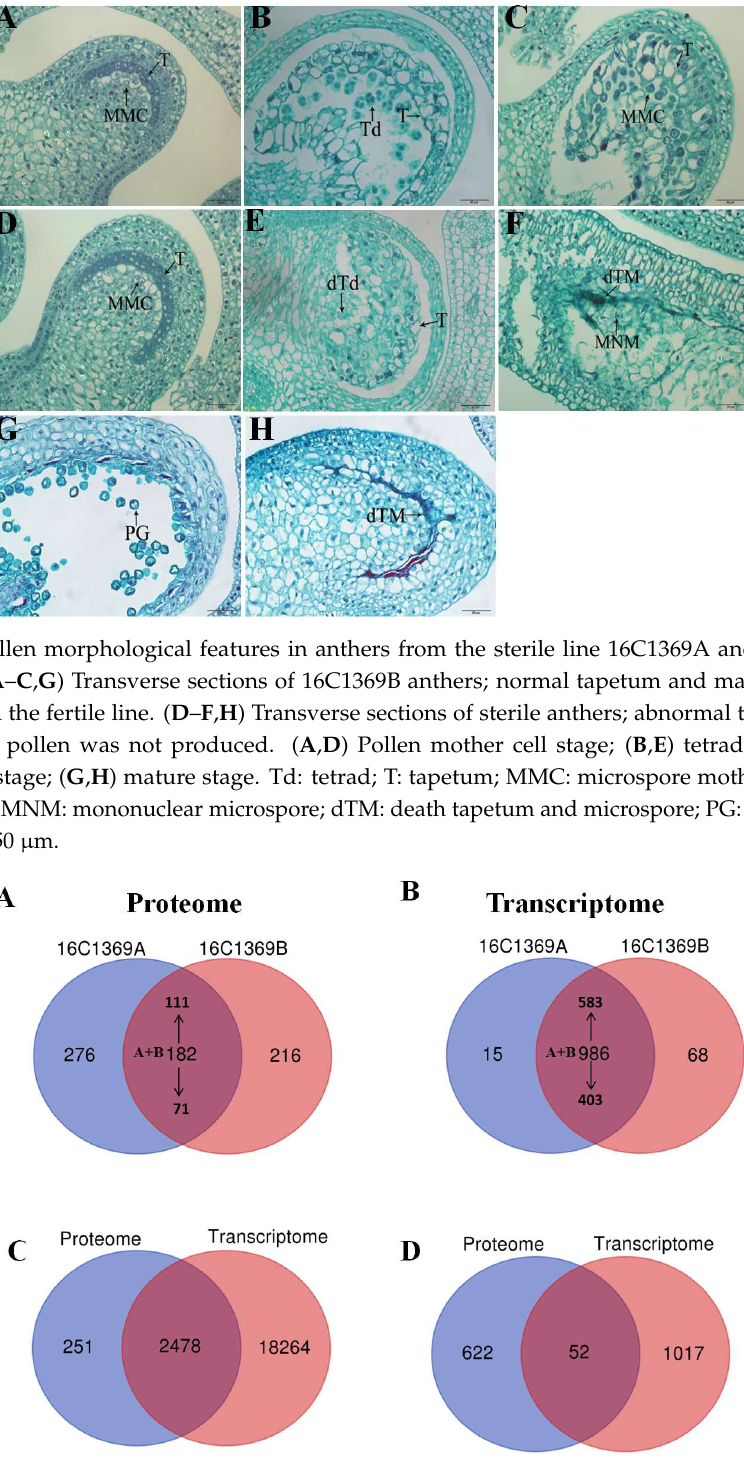
Figure 2. Venn diagram of transcriptome and proteome. ( A ) Comparison of differentially expressed proteins (DEPs) identified in the sterile 16C1369A and the fertile line 16C1369B; ( B ) comparison of differentially expressed genes (DEGs) identified in the sterile 16C1369A and the fertile line 16C1369B; ( C ) comparison of all the proteins and genes identified in the sterile 16C1369A and the fertile line 16C1369B; ( D ) comparison of all the DEPs and DEGs identified in the sterile 16C1369A and the fertile line 16C1369B. “ ↑ ” and “ ↓ ” indicate up-regulated and down-regulated, respectively. “A + B” indicates the DEPs and DEGs identified in both lines.